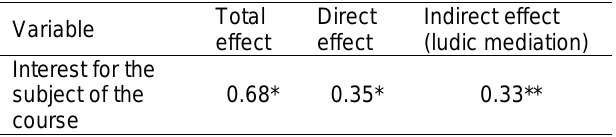
Table 4. Effects on the Willingness to continue